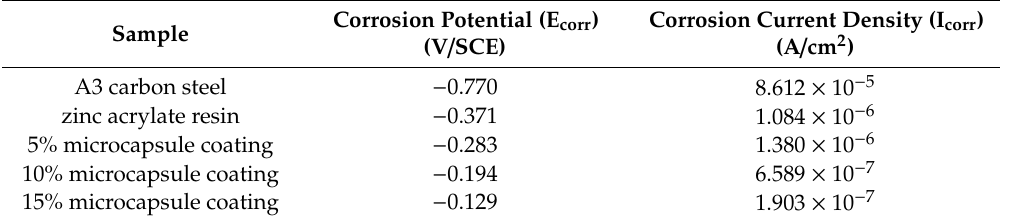
Table 2. Potentiodynamic polarization curve parameters for the A3 carbon steel, zinc acrylate resin, and 5%, 10%, and 15% microcapsule coatings in